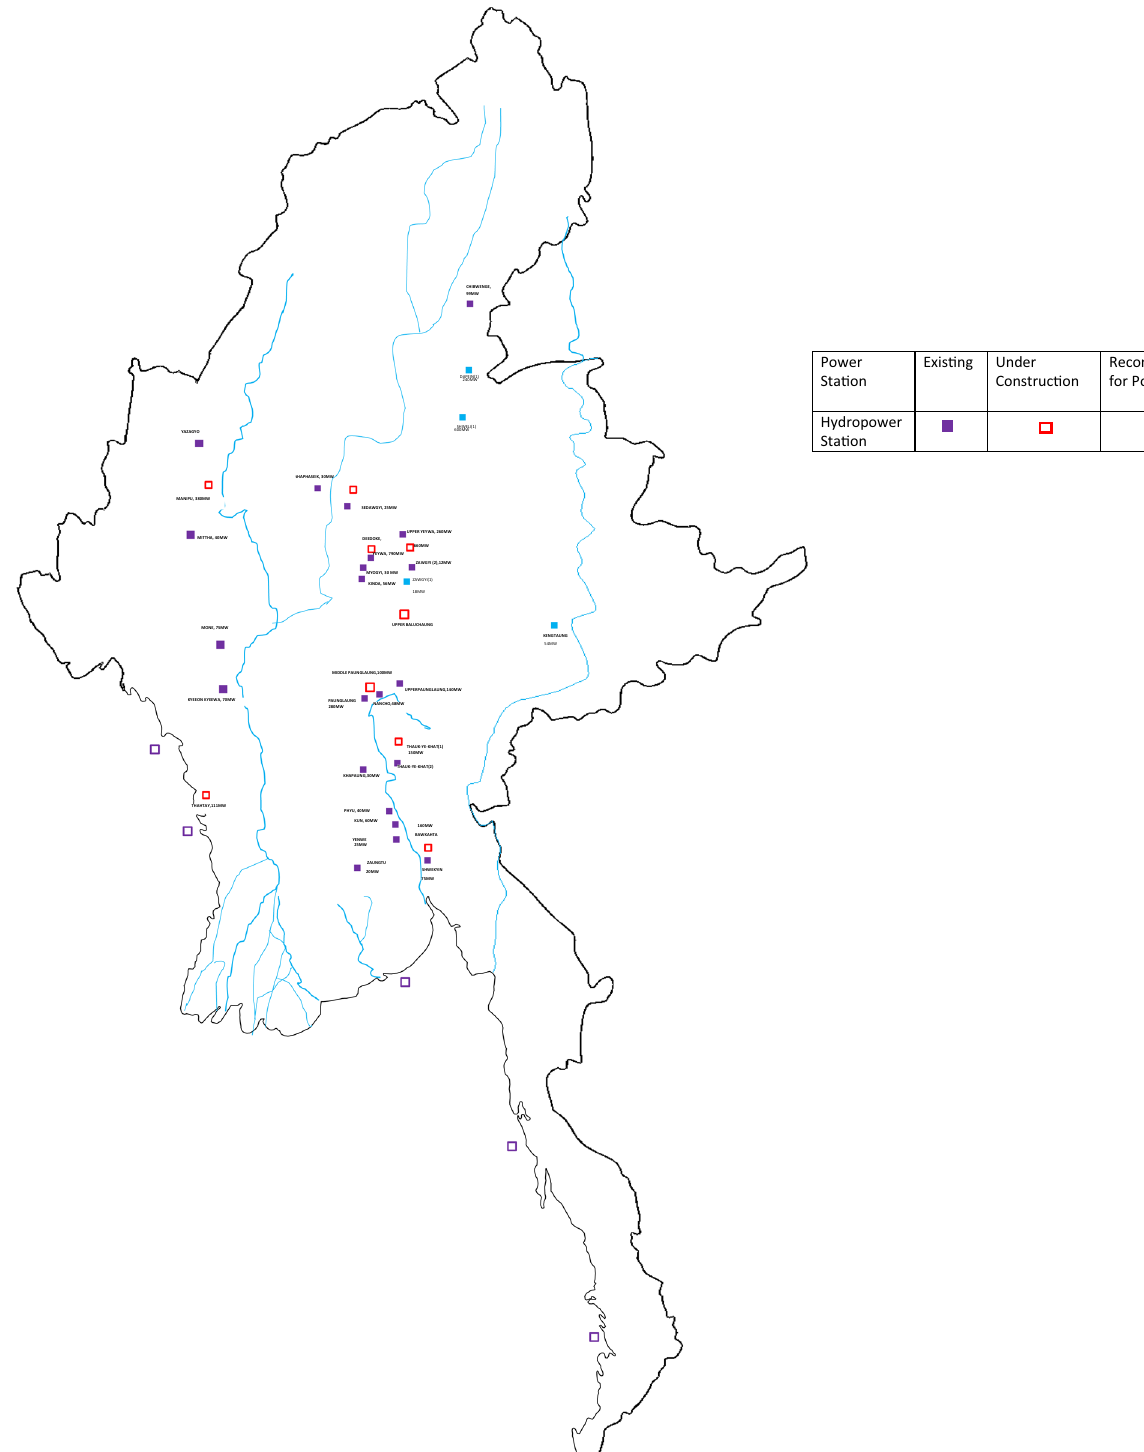
Fig. 1 Myanmar national grid system (existing and under